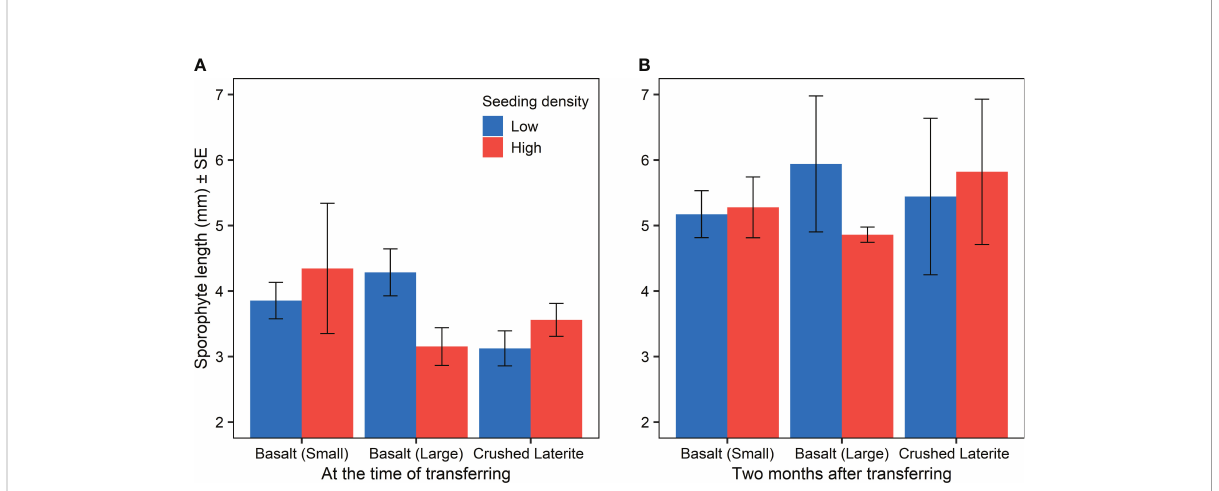
FIGURE 3 Sporophyte length (mean ± SE) on green gravel for each substratum and seeding density (A) at the time of transferring into aquarium tanks (three months post-seeding), and (B) two months after transferring. Colours refer to the initial seeding